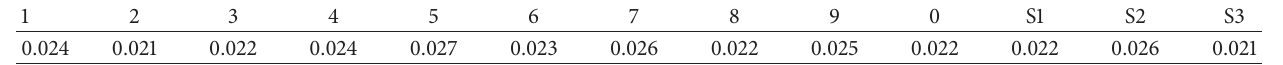
Table 2: The runtime of hand gesture recognition.